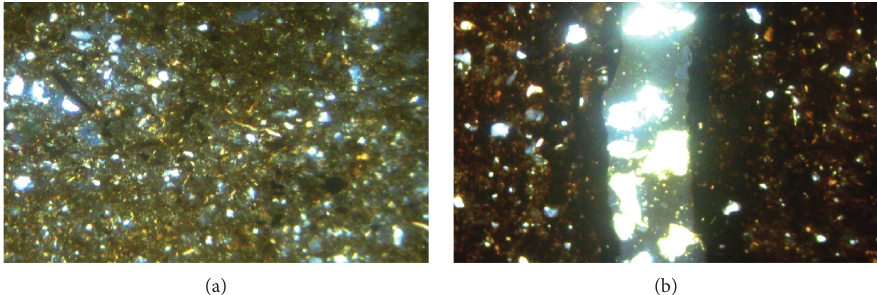
Figure 7: The anisotropy of soft clay at Site 6 (Ca Mau province) by microscopic observation: (a) vertical direction; (b) horizontal direction.